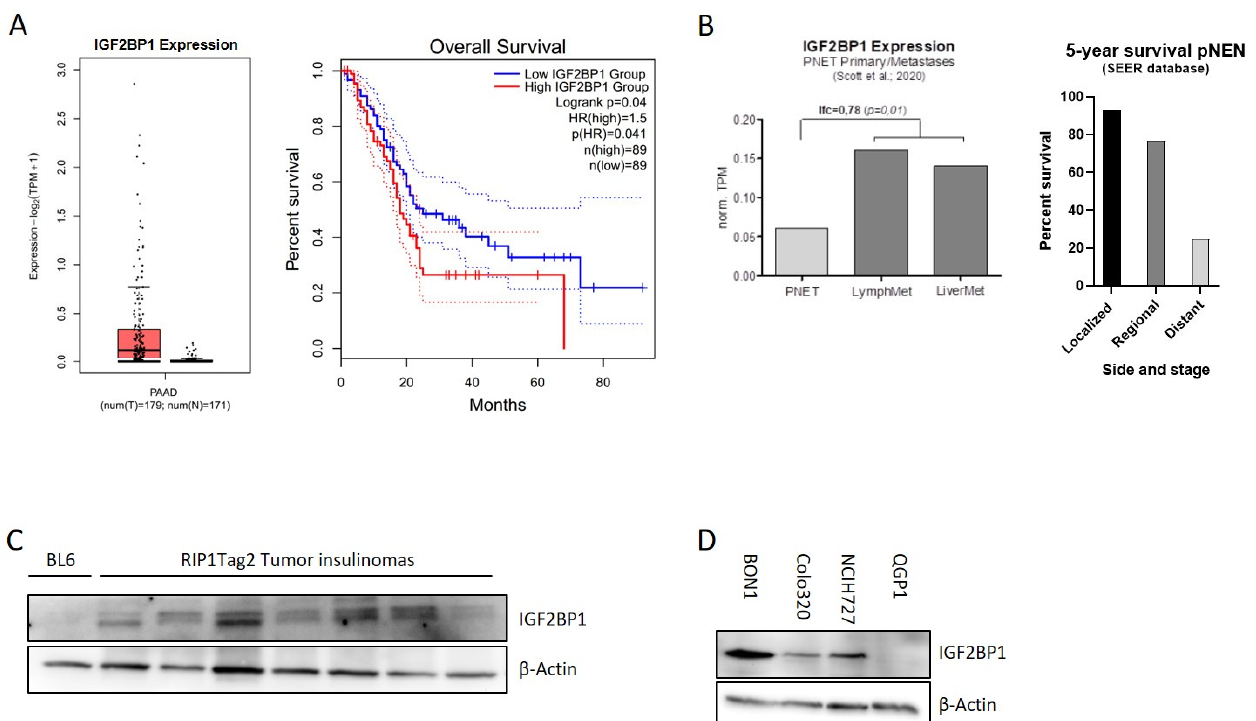
Figure 1. IGF2BP1 is highly expressed in pNEN and is associated with worse prognosis. ( A ) IGF2BP1 mRNA expression in PDAC tumors matched with TCGA normal and GTEx data (left panel) and median overall survival in PDAC with low (blue line) or high (red line) IGF2BP1 expression (right panel). Blot generated using GEPIA2 database. ( B ) IGF2BP1 mRNA expression in primary pancreatic neuroendocrine tumors (pNEN) compared to corresponding lymph node and liver metastasis (left panel; data derived from Scott et al., 2020), as well as 5-year survival rate of pNEN patients (right panel) depending on cancer stage: Localized (tumor diagnosed at a localized stage), regional (tumor spreading to surrounding tissues and/or regional lymph nodes), distant (tumor with distant metastases). Data from Cancer.Net. ( C , D ) Western blots of IGF2BP1 protein levels in pooled benign murine pancreatic Islet (BL6) and individually isolated insulinomas of RIP1-Tag2 mice ( C ), as well as whole cell lysates from BON1, Colo320 and NCIH727 NEN cell lines ( D ). Actin served as loading control. The uncropped western blot figures were presented in Figure S7.